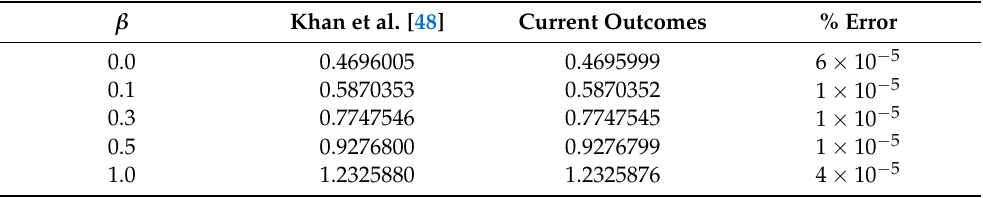
Table 1. An assessment value of − f (cid:48)(cid:48) ( 0 ) for dissimilar values of β with reference [48] when W = 0, γ = 0, M = S = 0.